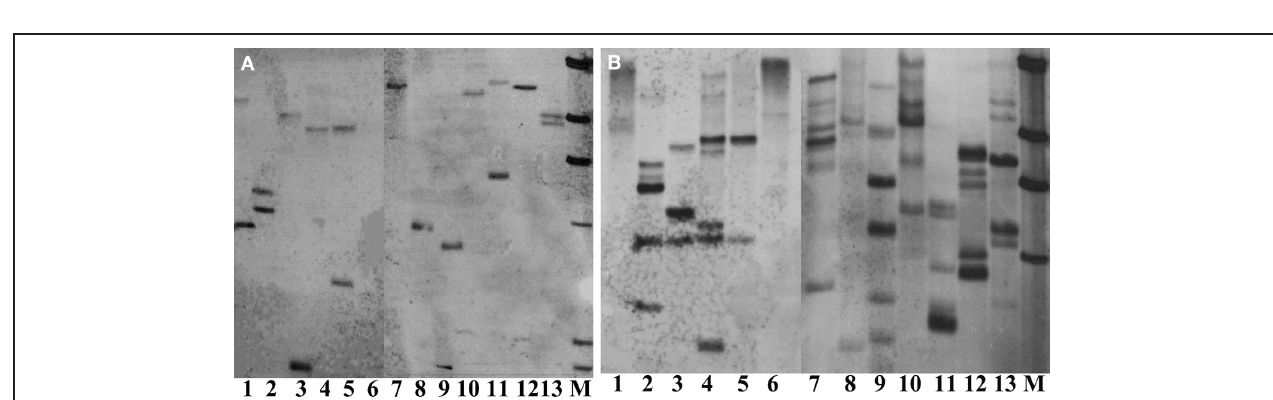
FIGURE 5 | Southern blot analysis on DNAs from two transgenic lines with 2 (A) and multiple copies (B) of transgenes respectively, digested with 13 different restriction enzymes and hybridized with the hpt probe.